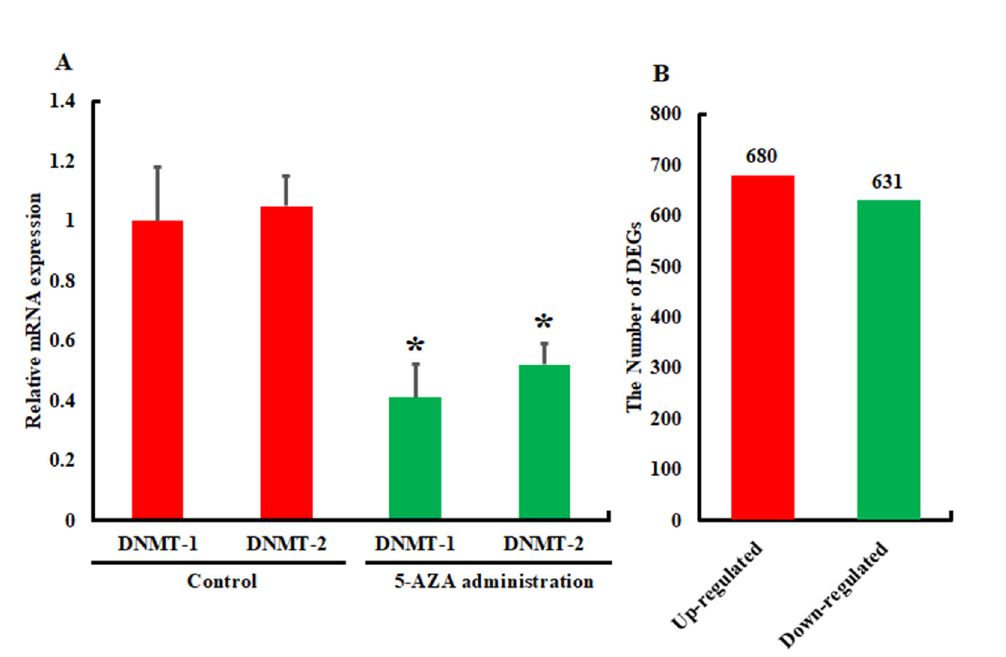
Figure 1. The inhibition of DNMTs and the comparison of the number of differentially expressed genes. ( A ): The inhibition of DNMTs analyzed by the qRT-PCR. ( B ): The levels of gene expression in 5-AZA- and bacterial-challenged groups compared to those in the control group. The differentially expressed genes were screened out by |log fold change (FC)| ≥ 1. Bars show the mean ± S.E. (n = 3), and asterisks indicate significant differences (* p < 0.05).